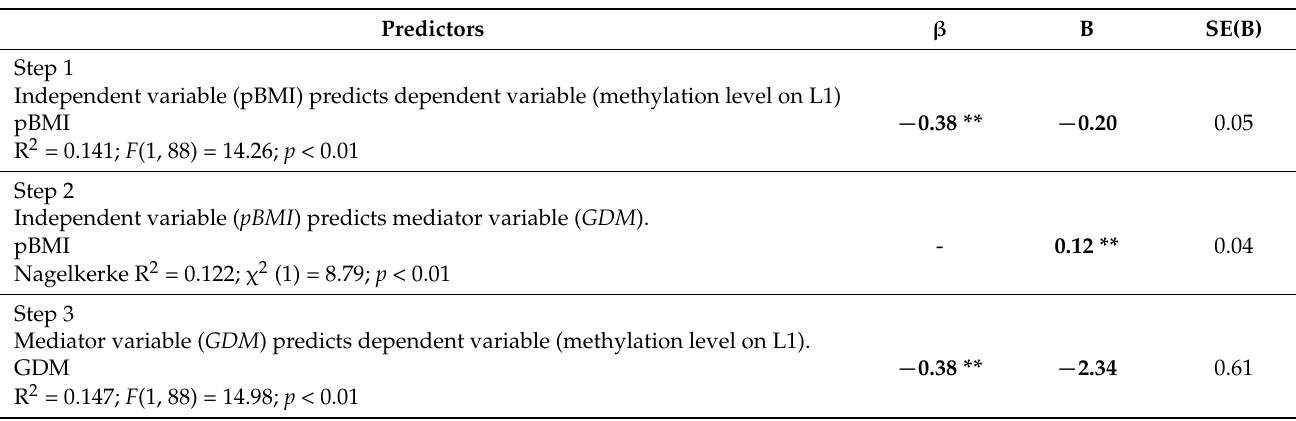
Table A2. Regression analysis testing the mediating role of gestational diabetes mellitus